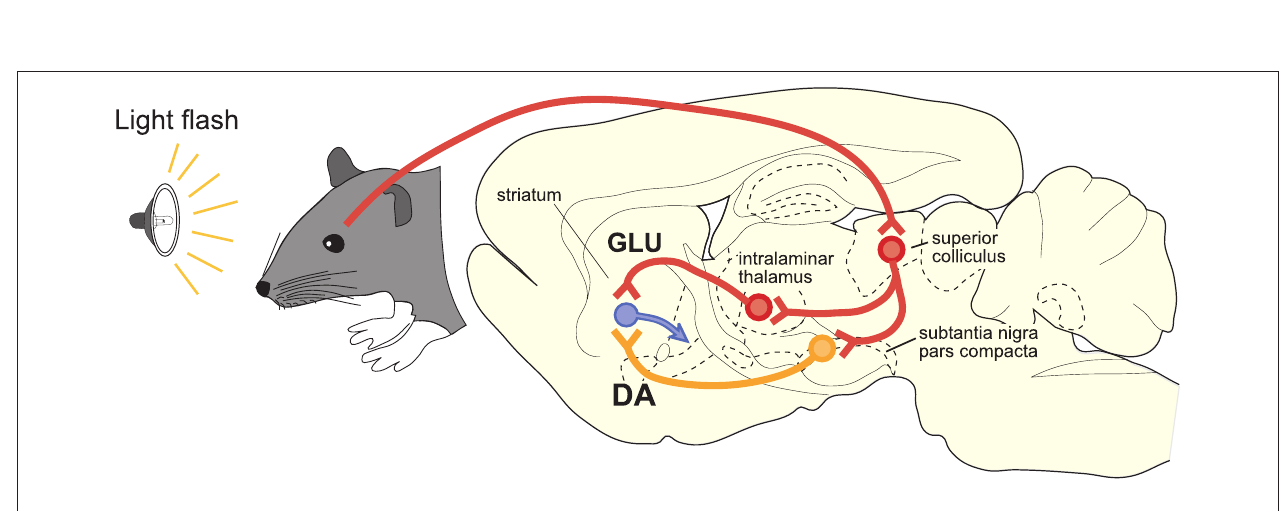
neurotransmitters used in branched connections from the superior colliclus are unknown. Consequent, potentially converging phasic inputs to the striatum from intralaminar nuclei (GLU, glutamate) and substantia nigra (DA, dopamine) are likely to play a critical role in reinforcement learning.